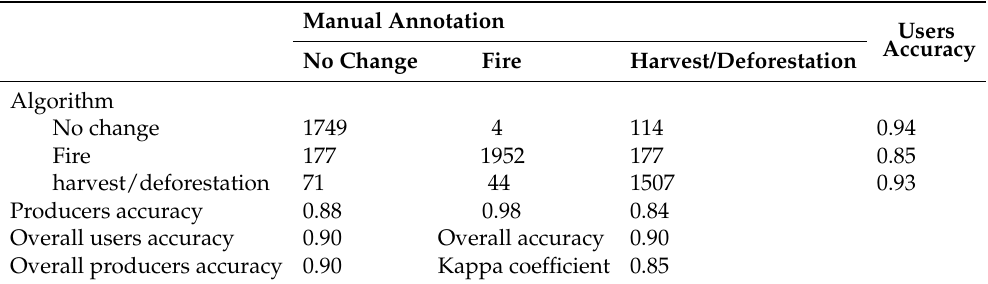
Table 1. Accuracies of disturbance type